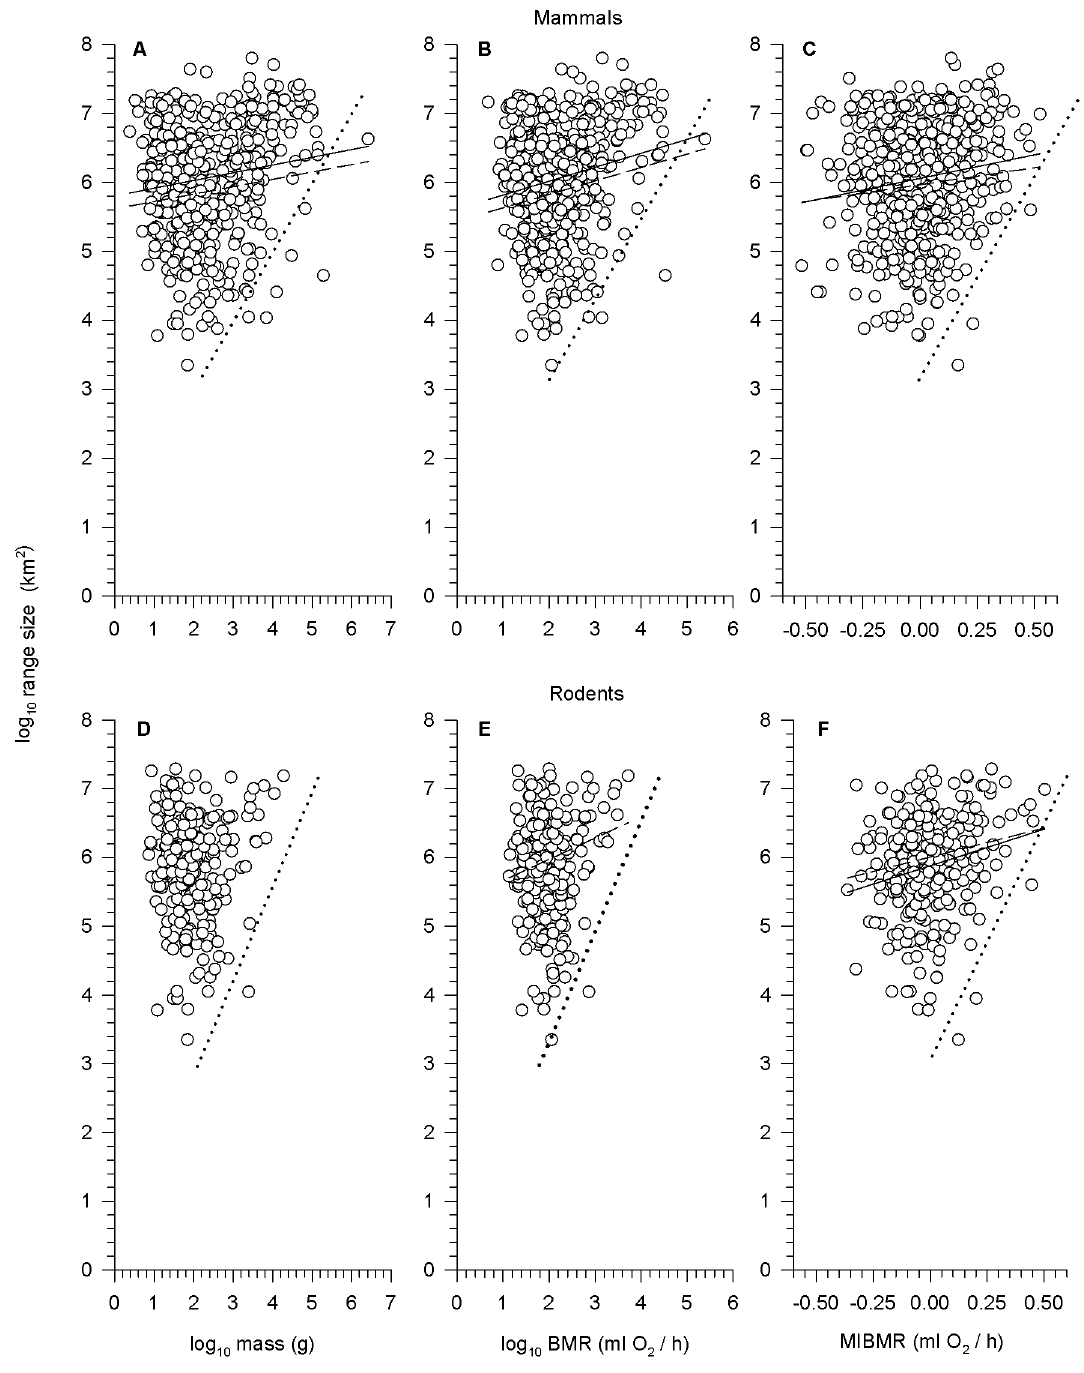
Figure 3. Among-species relationship between geographic range size and (a, d) mass, (b, e) BMR, and (c, f) MIBMR in all mammals and rodents. OLS (solid) and PGLS (dashed) regression lines are plotted where significant. Dotted lines were drawn by eye to illustrate the hypothesized functional constraint (see text). doi: 10.1371/journal.pone.0072731.g003 detected a transition in the body size-range size relationship body size-range size data set [65]; ~100 g in the entire around the modal mammal body size (~40 g in the expanded assemblage of mammals [111]). For larger species to the right